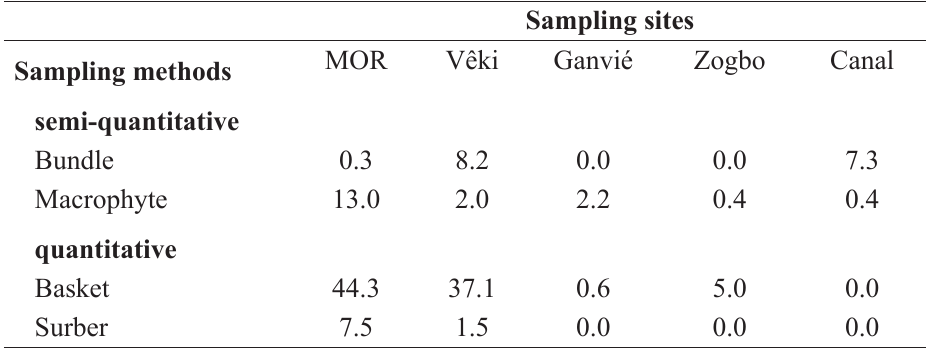
Table 2. Mean abundances of the amphipod Quadrivisio laleyei sp. nov., sampled with four different methods at five stations of the Nokoué lagoon. Bundle (ind.bundle -1 ) and basket (ind.m -2 ) methods: 7 monthly samplings in 2002–2003, n = 3; Macrophytes (ind.macrophyte -1 ) and Surber (ind.m -2 ) methods: 2 sampling periods (February and September 2006), (n =